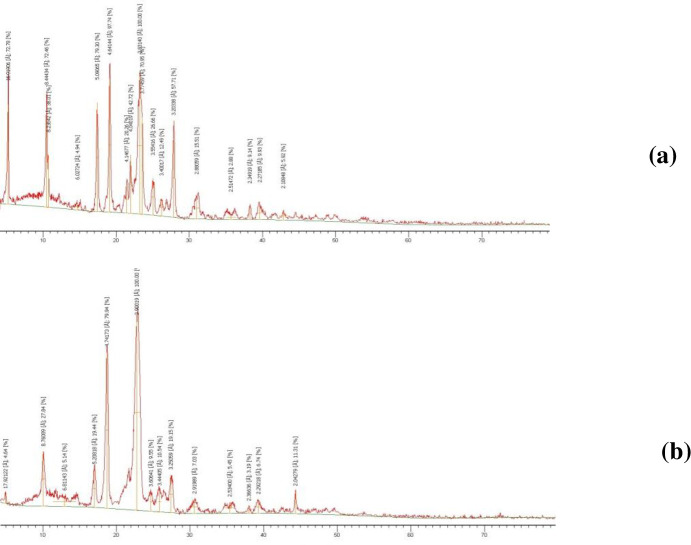
Powder X-ray diffraction spectra of drug powder (a) and optimized SD (b).